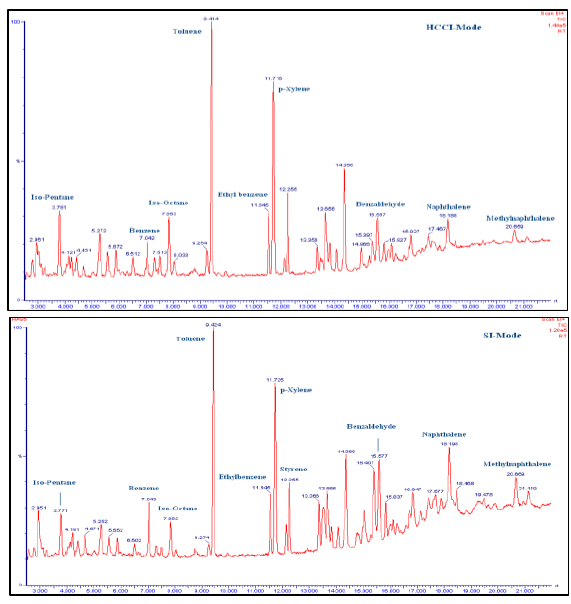
Fig. 3. The chromatograms obtained for the emission products from HCCI (upper) and SI mode (lower) of the engine at the same speed and load points, and running at lambda = 1